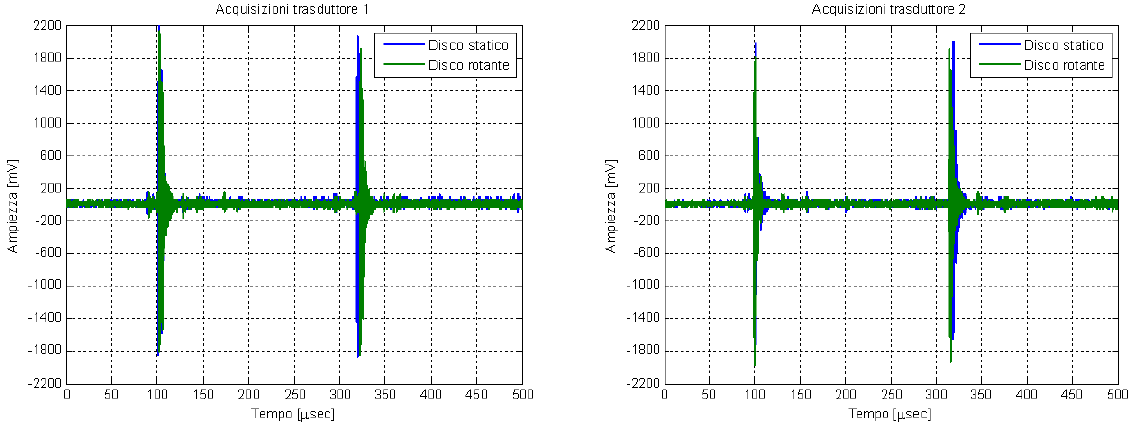
Figura 3: Confronto tra i segnali acquisiti dal trasduttore 1 e 2 in condizione statica e dinamica. Figure 3: Comparison between the signals acquired by transducers 1 and 2 in static and dynamic